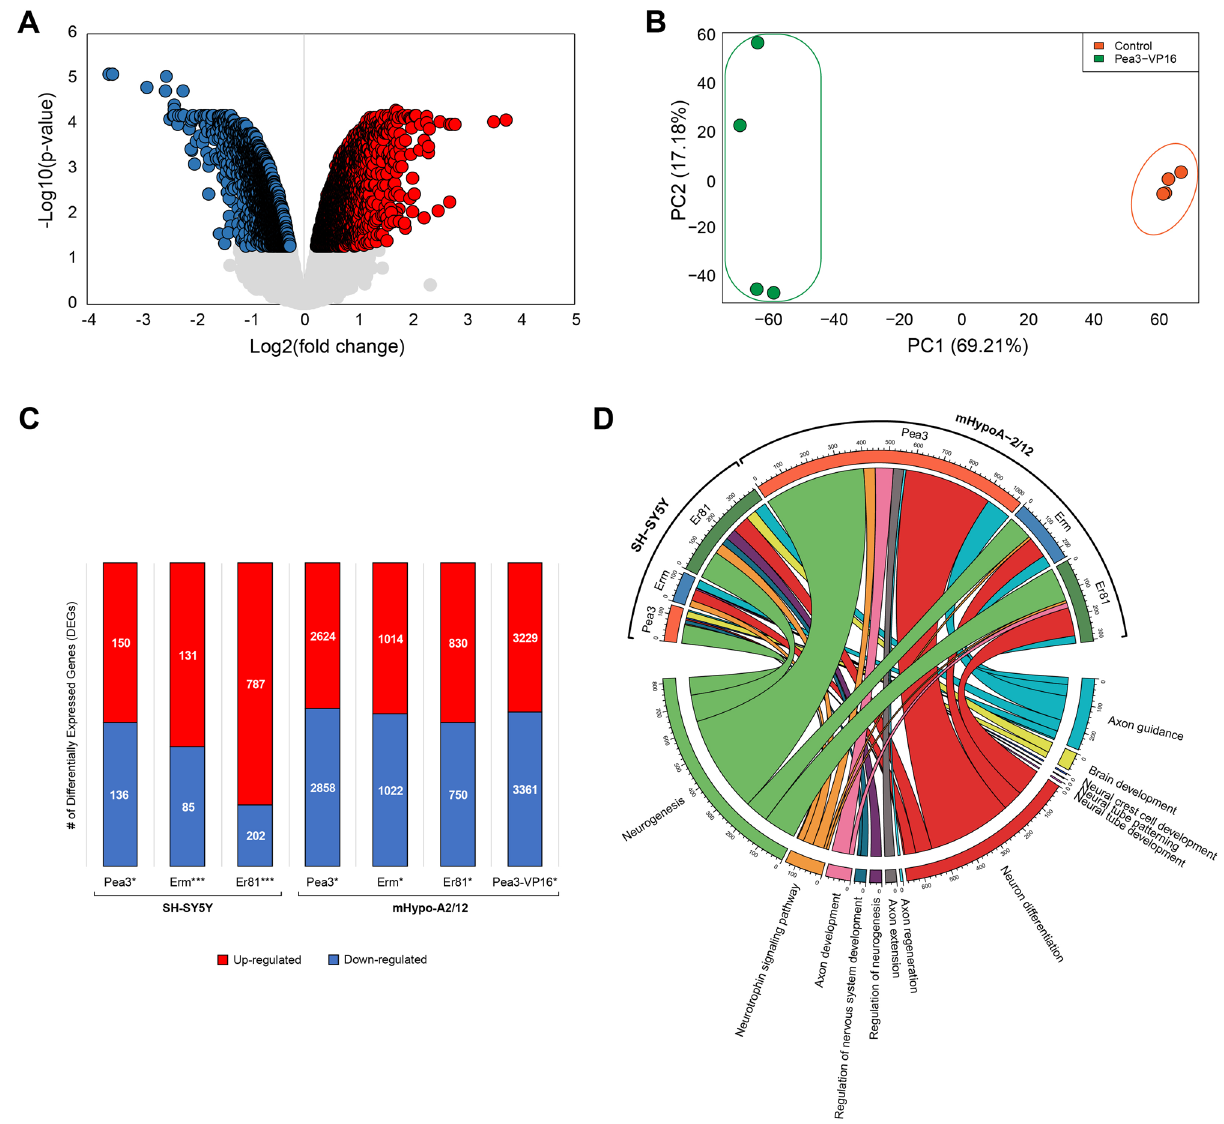
Figure 2. ( A ) Volcano plot showing the statistical significance ( p value) versus fold change at logarithmic scale in transcriptome analysis for the mHypoA2/12 cells transfected with Pea3-VP16 expression vector with respect to the control cells. Up-regulated genes are shown in red, whereas down-regulated genes are shown in blue. p values < 0.05; LIMMA. ( B ) Principal Component Analysis graph for the mHypoA2/12 transfected with Pea3-VP16 expression vector. The variance explained by each principal component (PC) was represented as percentage in paranthesis. ( C ) Graphic depiction of the number of differentially expressed genes in SH-SY5Y and mHypoA2/12 cells transfected with Pea3, ERM or Er81 expression vectors, or mHypoA2/12 transfected with Pea3-VP16 expression vector. Up-regulated genes are shown in red, whereas down-regulated genes are shown in blue. p values: * < 0.05; *** < 0.001; LIMMA. ( D ) Circos plot for selected pathways related to neuronal development and function among enriched pathways in SH-SY5Y and mHypoA2/12 cells transfected with Pea3, ERM or Er81 expression vectors. The markers represent the number of genes enriched in each pathway. p values: < 0.05; Fisher’s Exact